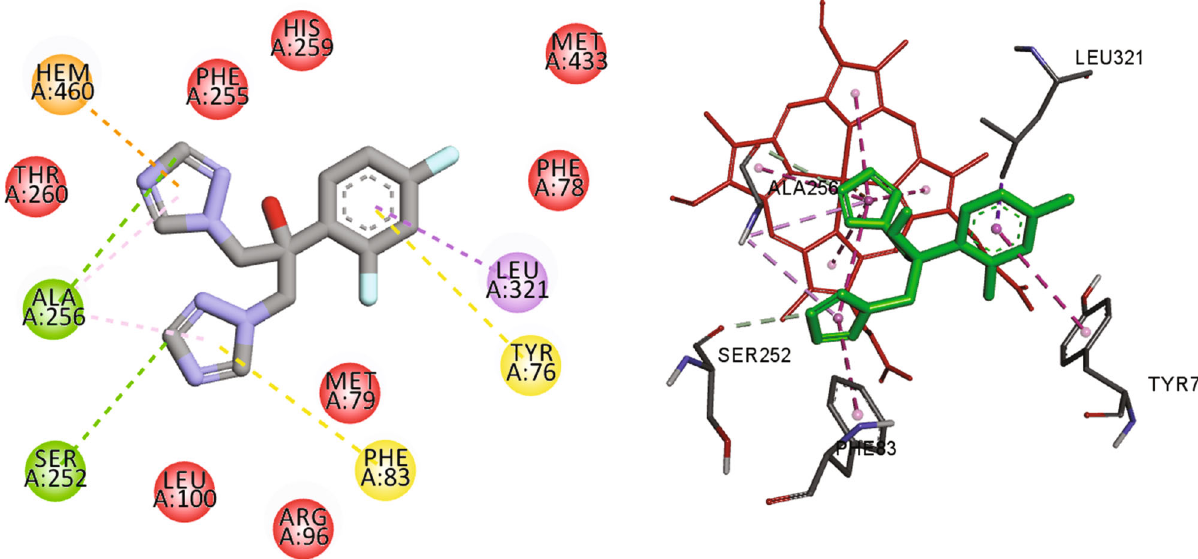
Figure 3: 2D and 3D interaction of fl uconazole-in cytochrome P der Waals, orange: pi-cation, yellow: pi-pi, purple: pi-alkyl).